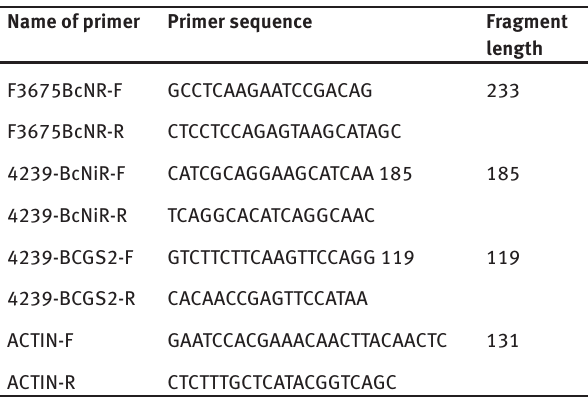
Table 2: The primers for RT-qPCR were as follows. Name of